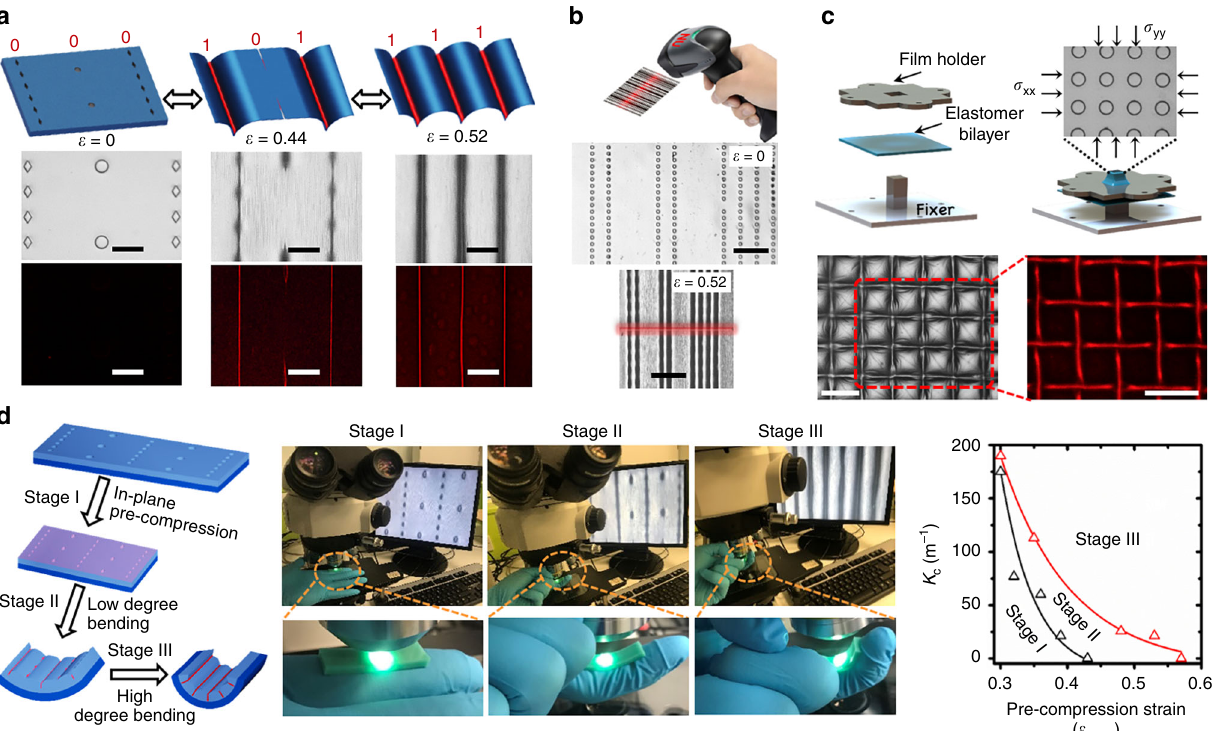
Fig. 4 Demonstration of application concepts. a An in-plane logic strain sensor with stepwise responses for large deformation sensing. b A 2D spy barcode design with a state of ‘ OFF ’ at ε = 0 and an ‘ ON ’ state at ε = 0.52. c An adaptive topo-optical grid under equi-biaxial compression. d A fl exible tactile sensor to detect the change on local curvature with (left) schematic illustration of sensing principle, (middle) observation of conformal sensing under re fl ective microscopy, (right) phase diagram of the conformal tactile sensing. All scale bars are 100 μ